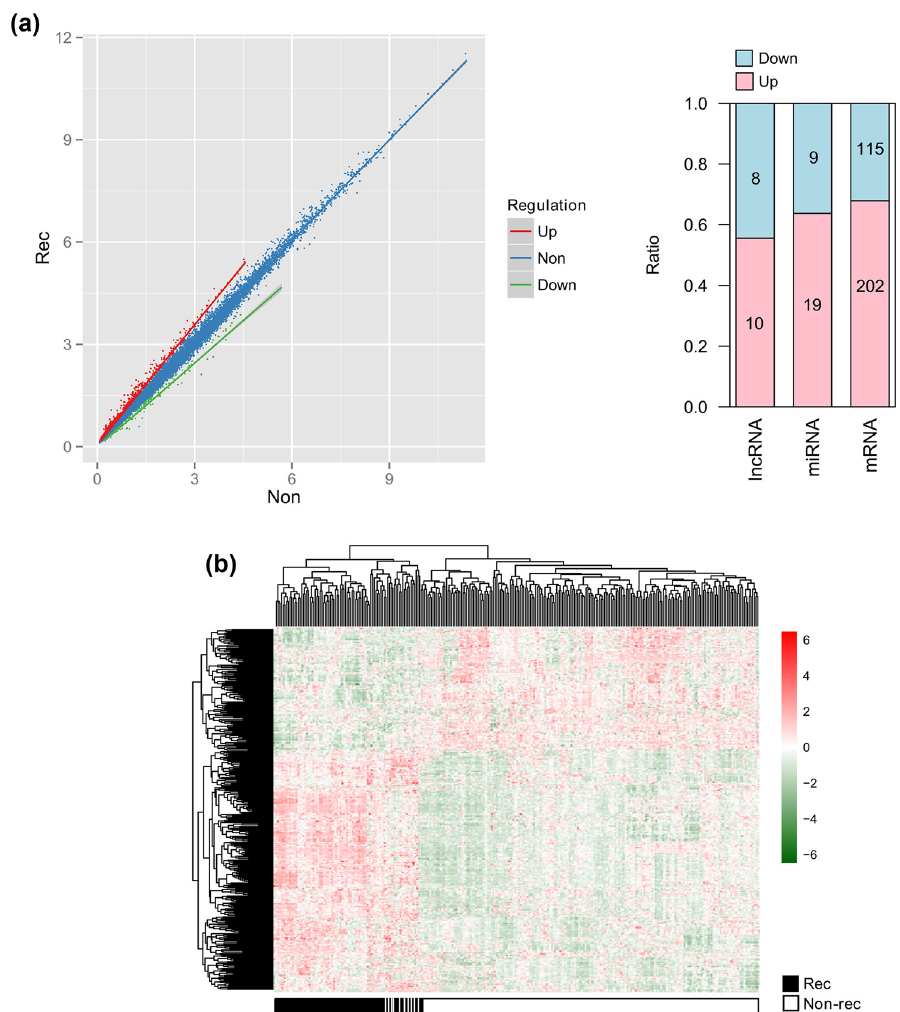
Figure 1: Di ff erentially expressed lncRNAs, miRNAs, and mRNAs of recurrence and nonrecurrence patients. ( a ) Left image is a scatterplot for di ff erentially expressed RNAs. Lateral axis represents nonrecurrence samples; vertical axis represents recurrence samples. Upregulated, downregulated, and nonregulated RNAs are shown in red, green, and blue spots, respectively. Right image shows ratios of up - and downregulated RNAs. ( b ) Heatmap displays di ff erentially expressed RNAs in recurrence and nonrecurrence